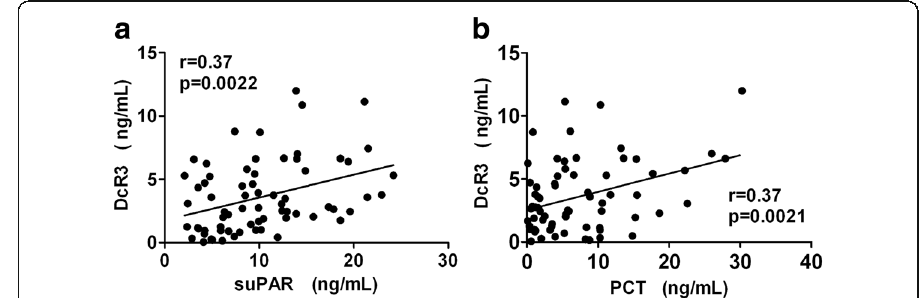
Fig. 2 Correlation between DcR3 and PCT ( a , r = 0.37, p = 0.0021), DcR3 and suPAR ( b , r = 0.37, p = 0.0022),